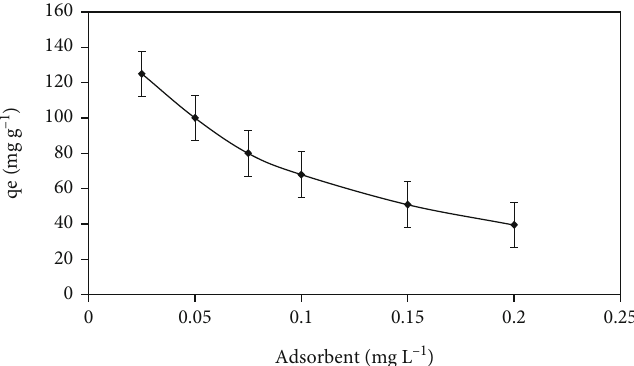
Figure 6: Graph of adsorbent (CV) e ff ect on PSS (adsorbent dose: 0.05gL -1 ; room temperature; and contact time: 3 hrs).